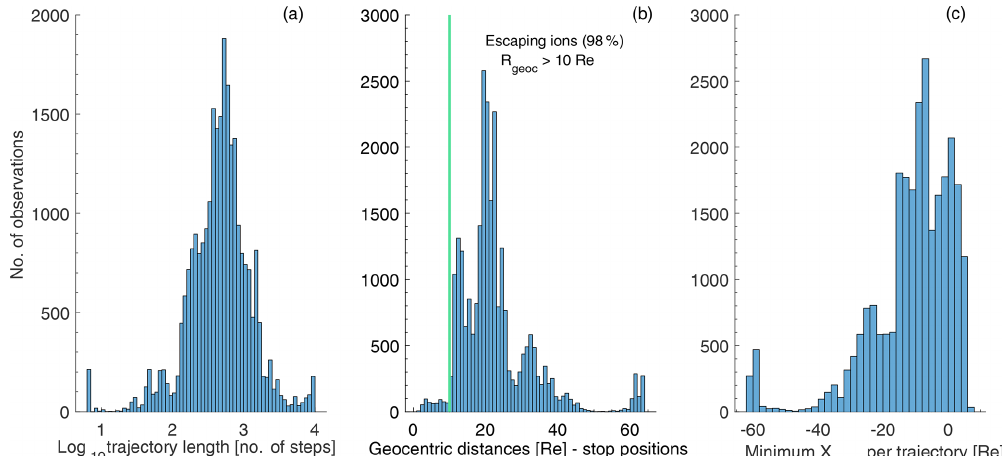
Figure 5. (a) Length of the 26200 O + trajectories in our sample. Note the logarithmic scale. (b) Final positions expressed in the geocentric distance R given in Re (see text for definition). (c) Minimum X distance for each